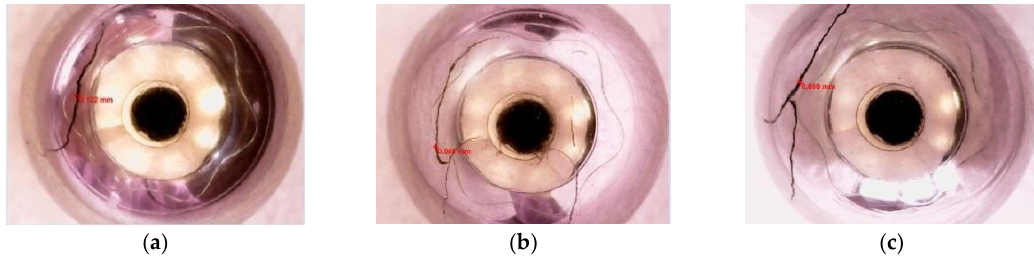
Figure 8. Samples of defective steel balls. ( a ) Linear cracks; ( b ) arc cracks; and ( c ) cross cracks.